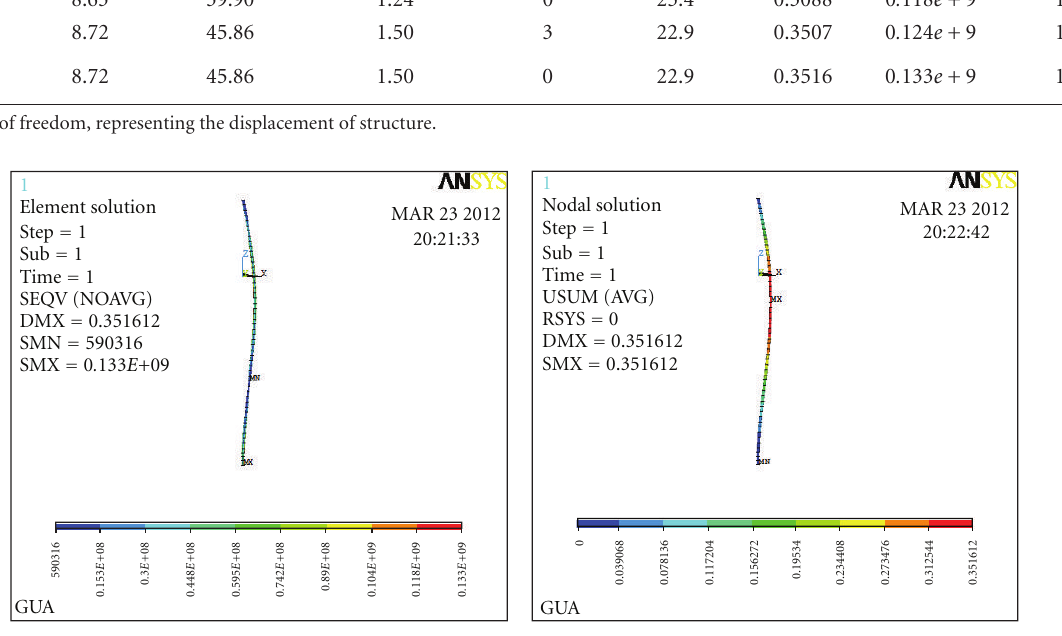
Figure 10: Stress and deformation of